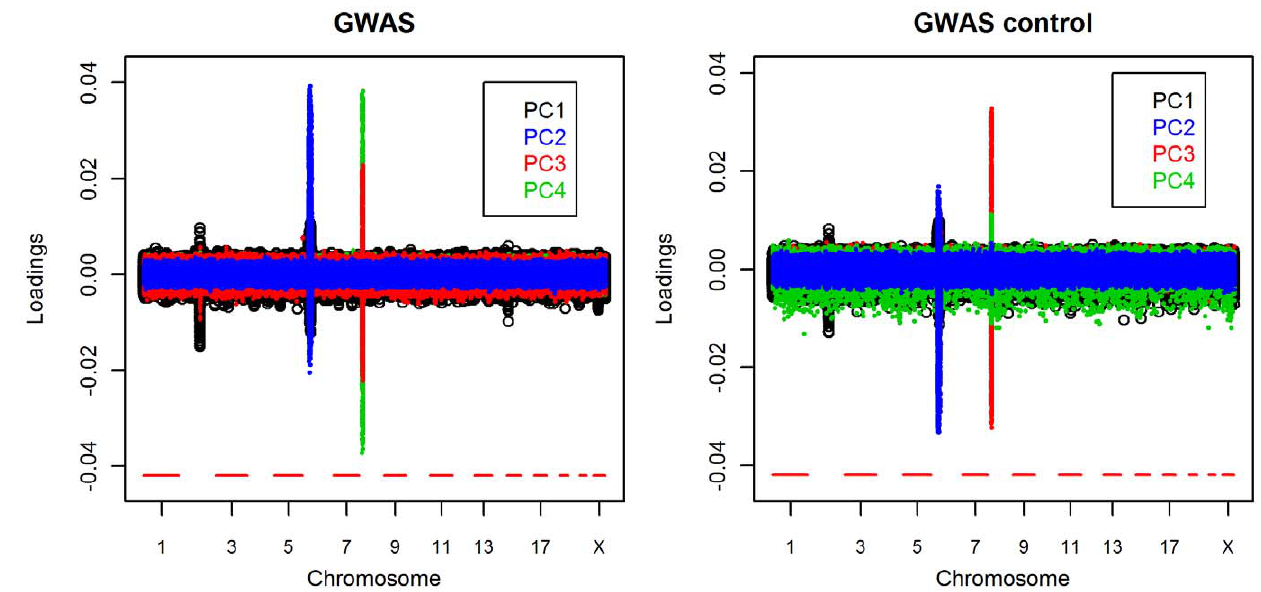
Figure 5. Loadings for the first 4 PCs. GWAS PCA (left panel) and GWAS control PCA (right panel) loadings are plotted showing peaks on chromosome 2, 6 and 8.